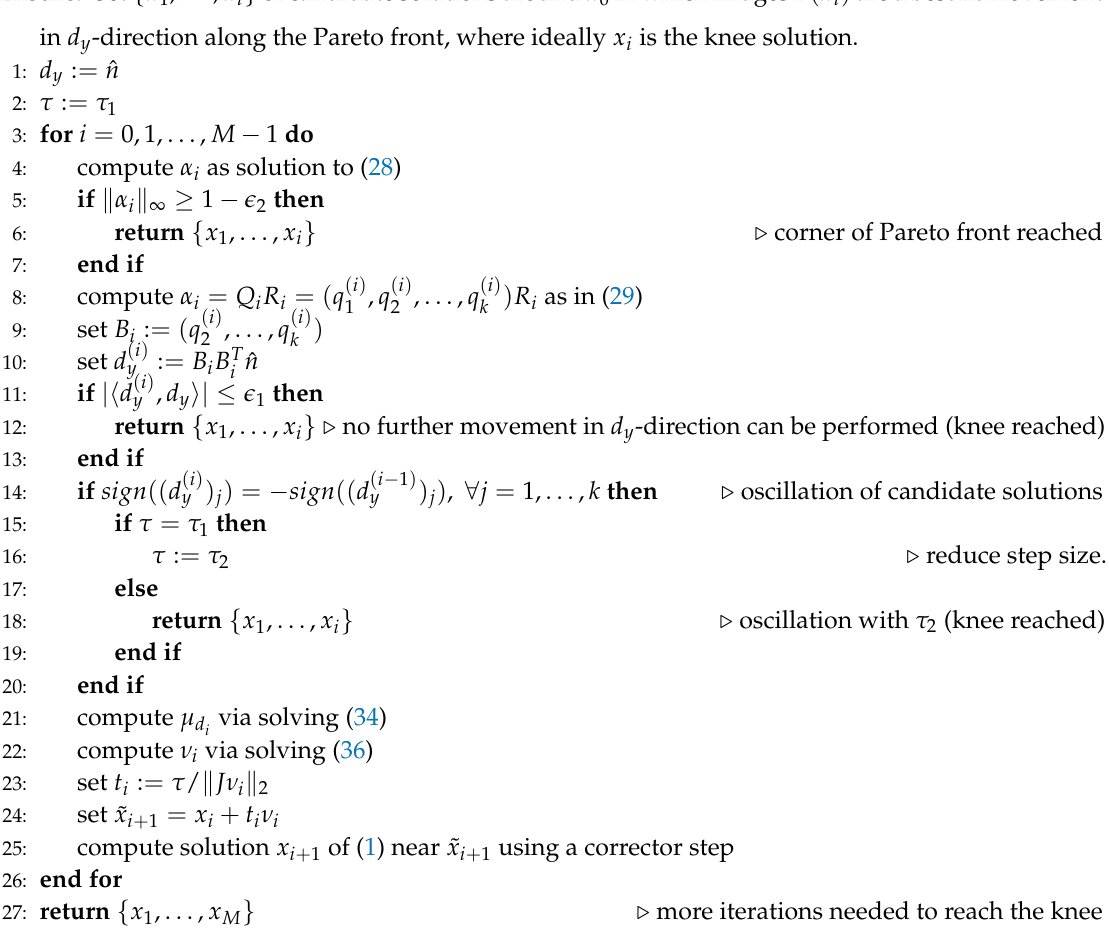
Algorithm 1 Pareto Explorer for finding the